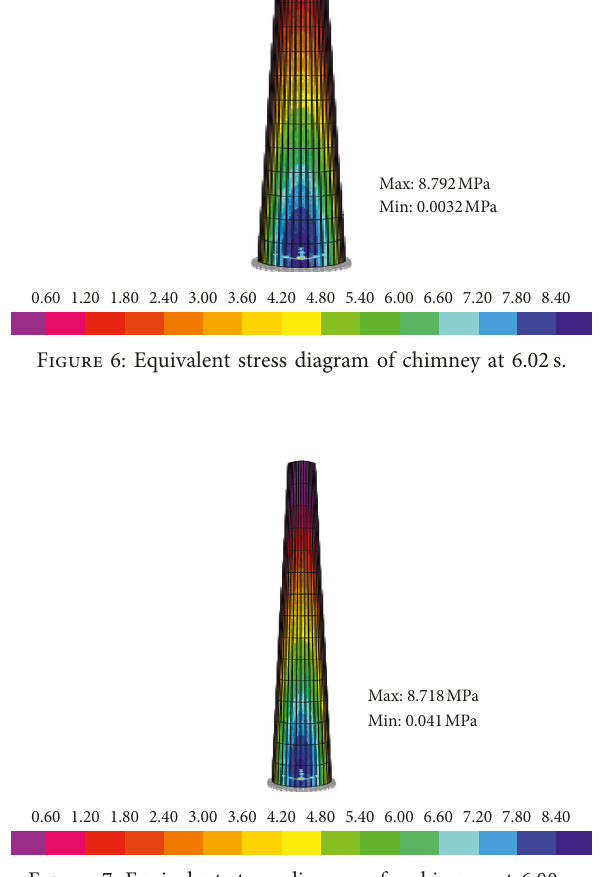
Figure 7: Equivalent stress diagram of a chimney at 6.00s.